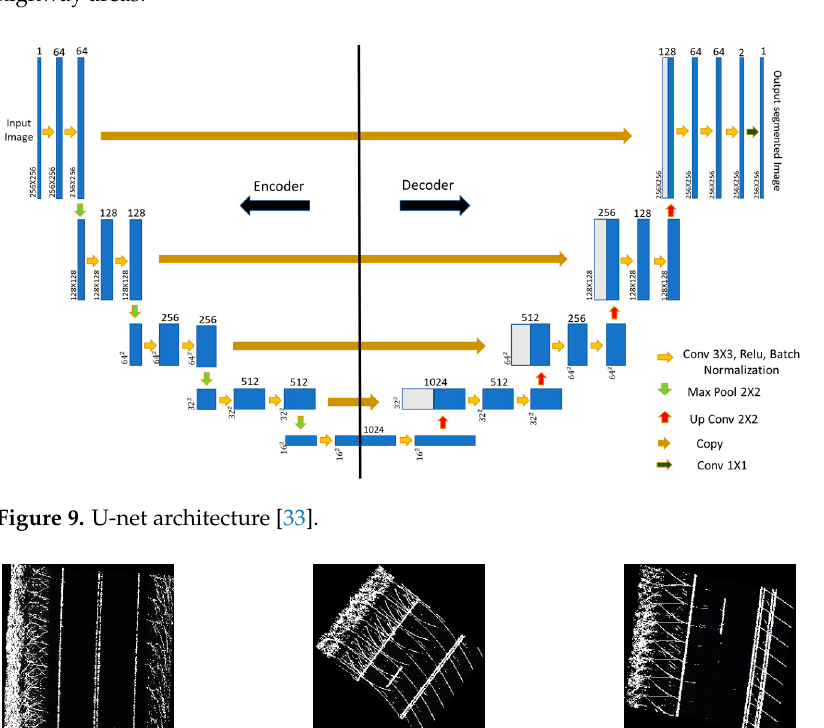
Figure 10. LiDAR intensity images for different lane marking patterns in target domain datasets: ( a ) one-lane highways with dual lane markings at the center, ( b ) dual lane markings at the edge, and ( c ) pair of dual lane markings at the edge.